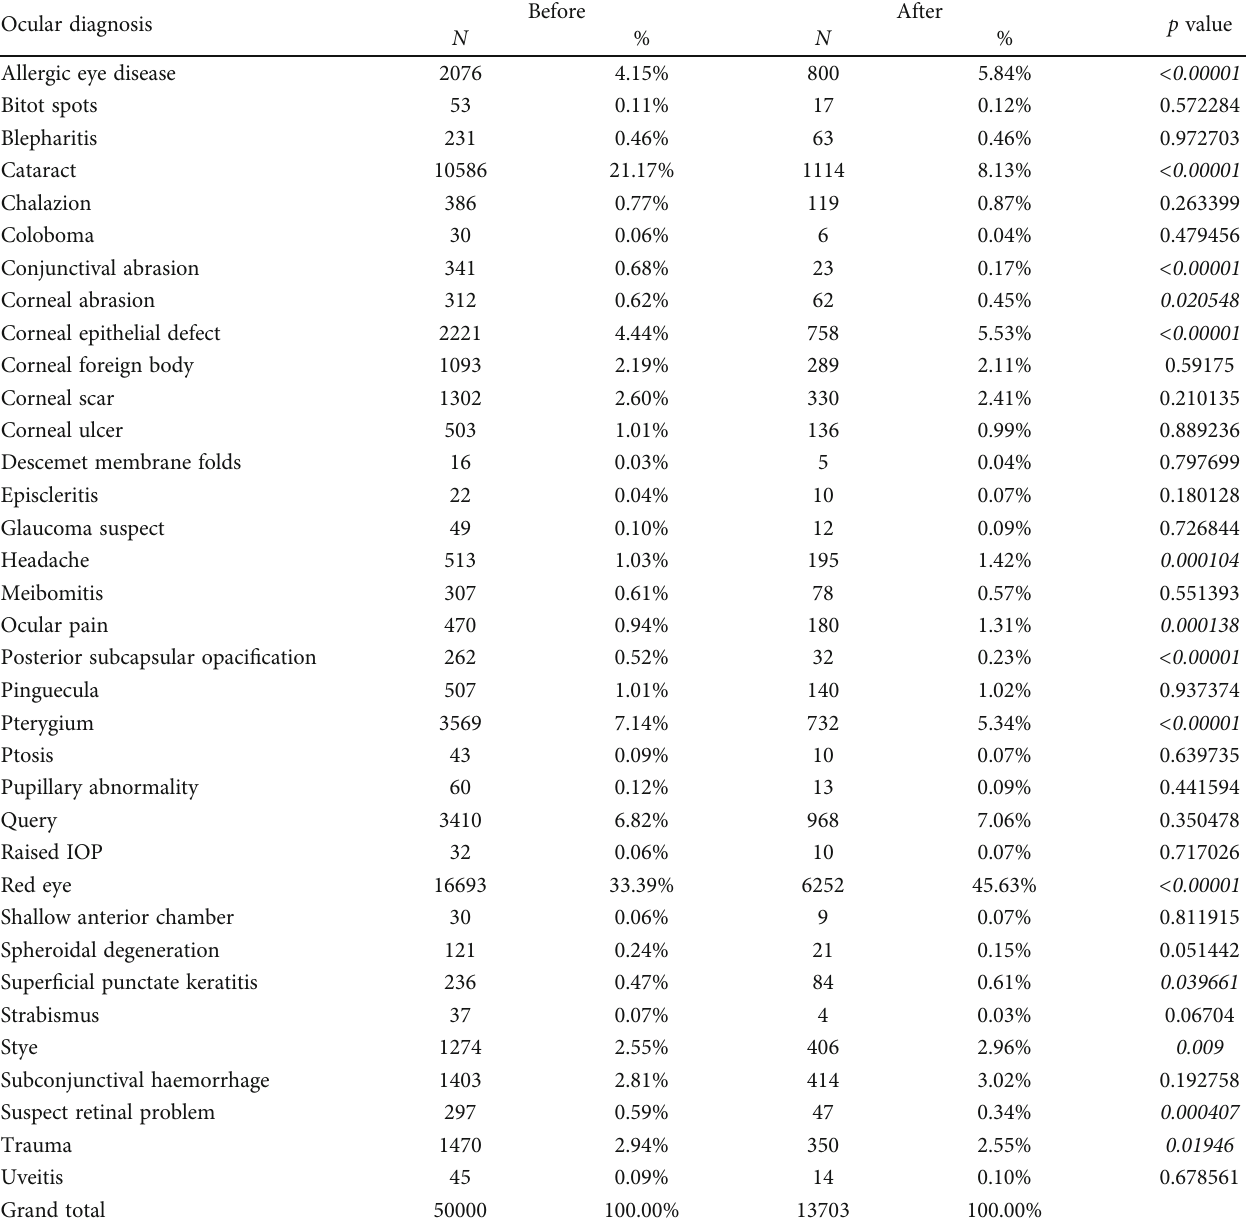
Table 3: Comparative description of ocular diagnosis referral before and after the implementation of speci fi c teleophthalmology referral